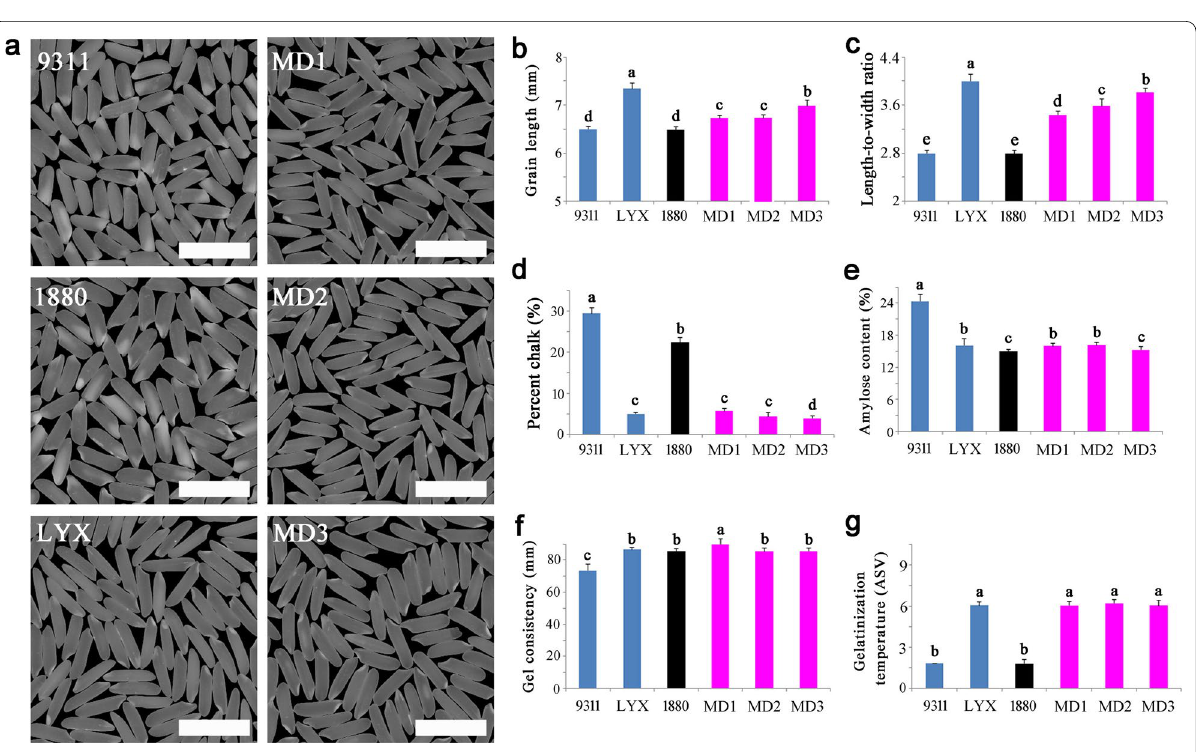
s.d., n 15. Letters indicate a significant difference at the 5% significance ± =